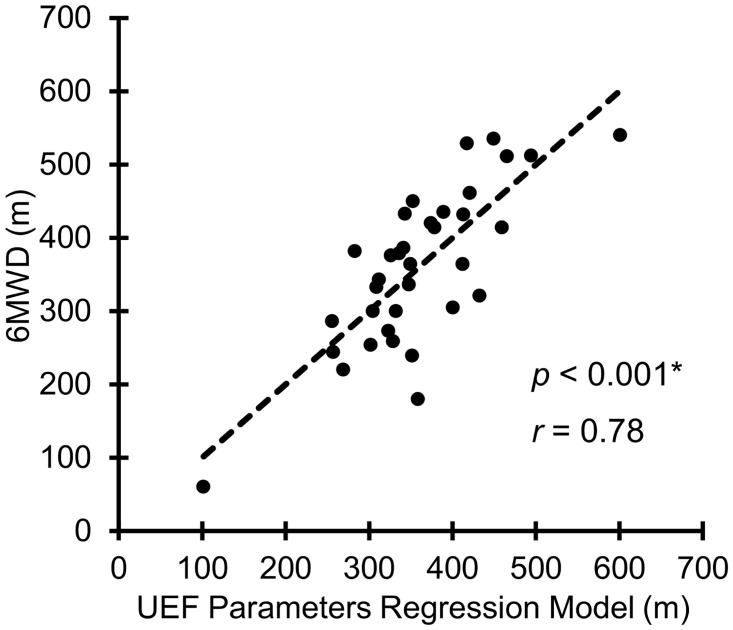
Multivariable regression model; dependent variable: 6MWD and independent variables: UFM parameters with significant correlation with 6MWD (i.e., speed, power, moment, speed variability, flexion number), age, gender, and BMI.